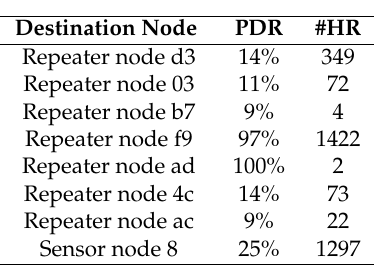
Figure 12. Network stability: the number of path_create and path_delete events generated per day over a month. The top line shows the total number of active links, as a reference: ( a ) Grizzly Ridge; and ( b ) Bucks Lake. Table 7. List of neighbors of sensor node 7 at Grizzly Ridge, with link quality and number of associated health reports. The mote does not constantly have two neighbors with high PDR that it can use as parents. It thus has to associate with neighbors with low link quality. Repeater nodes 03, b7, f9, 4c, ac are annotated in Figure